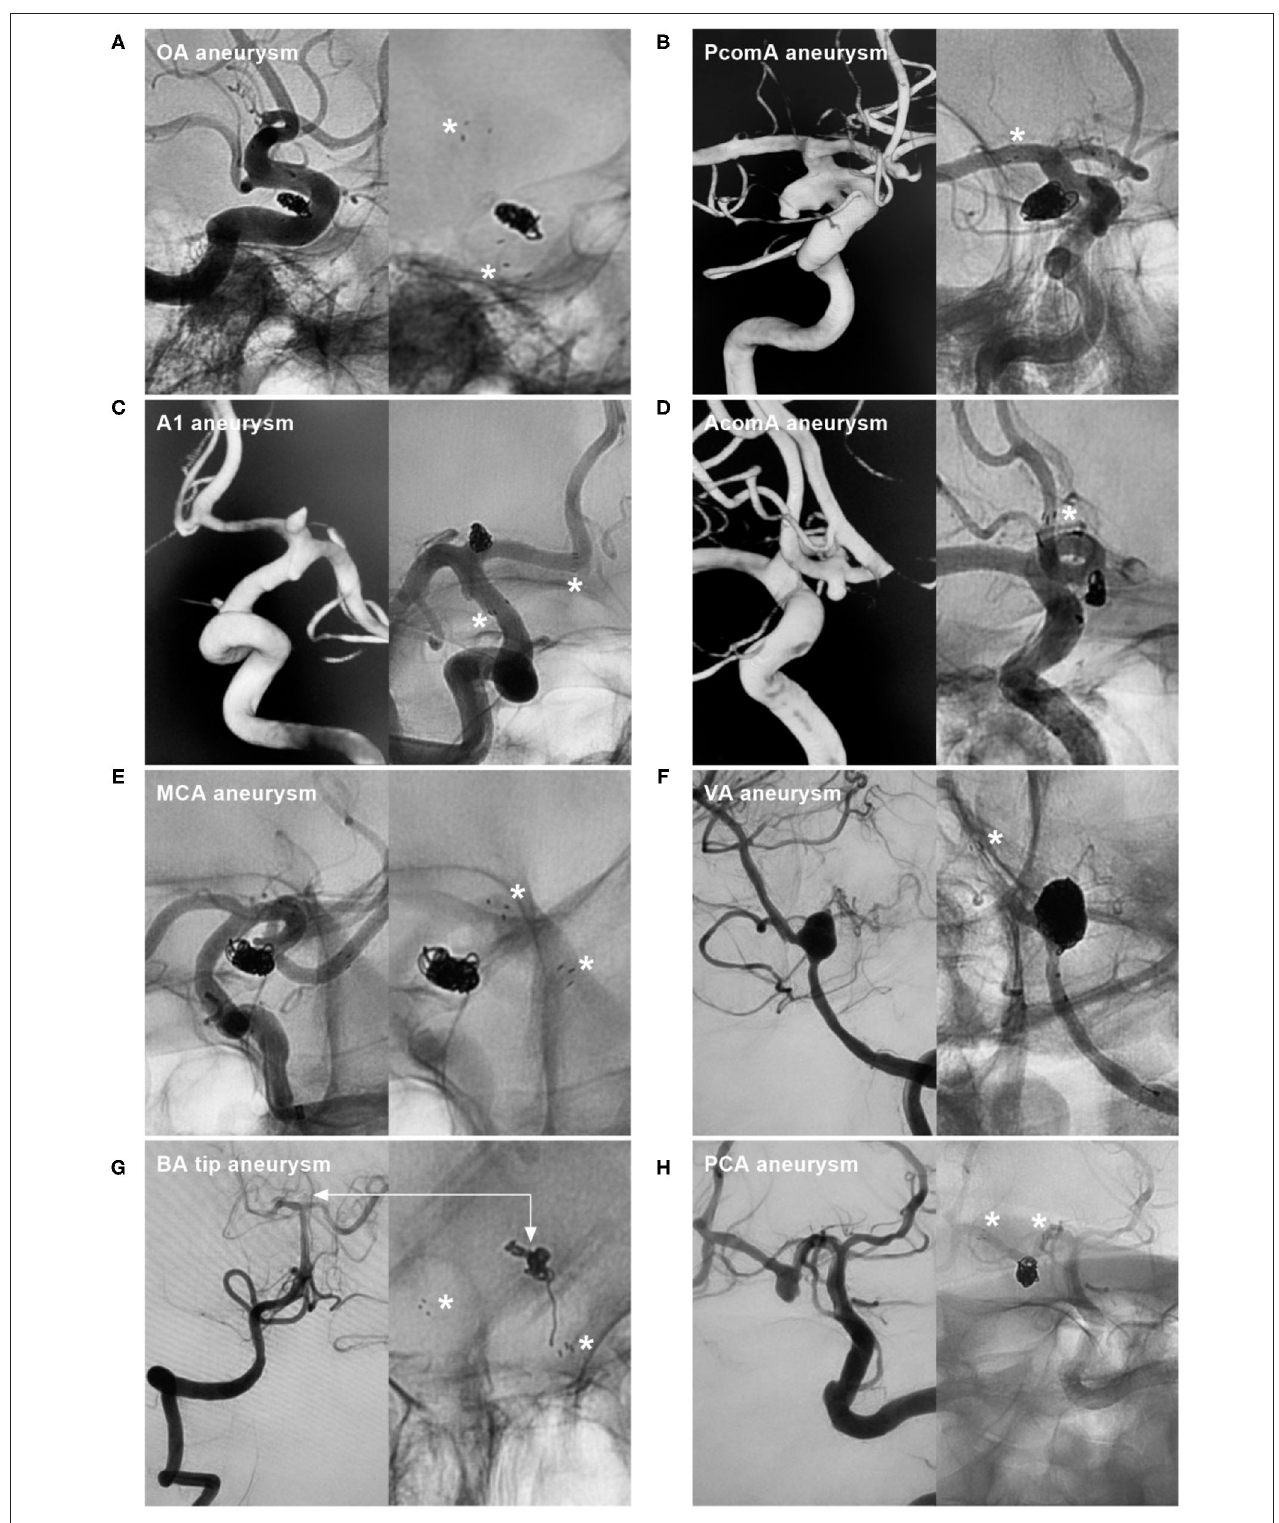
FIGURE 1 | NAS application to treat aneurysms at various locations. (A) NAS-assisted coiling of an OA aneurysm; the asterisks in the right image indicate proximal and distal markers. (B) NAS-assisted coiling of a PcomA aneurysm; the asterisk in the right image indicates the distal marker. (C) NAS-assisted coiling of an